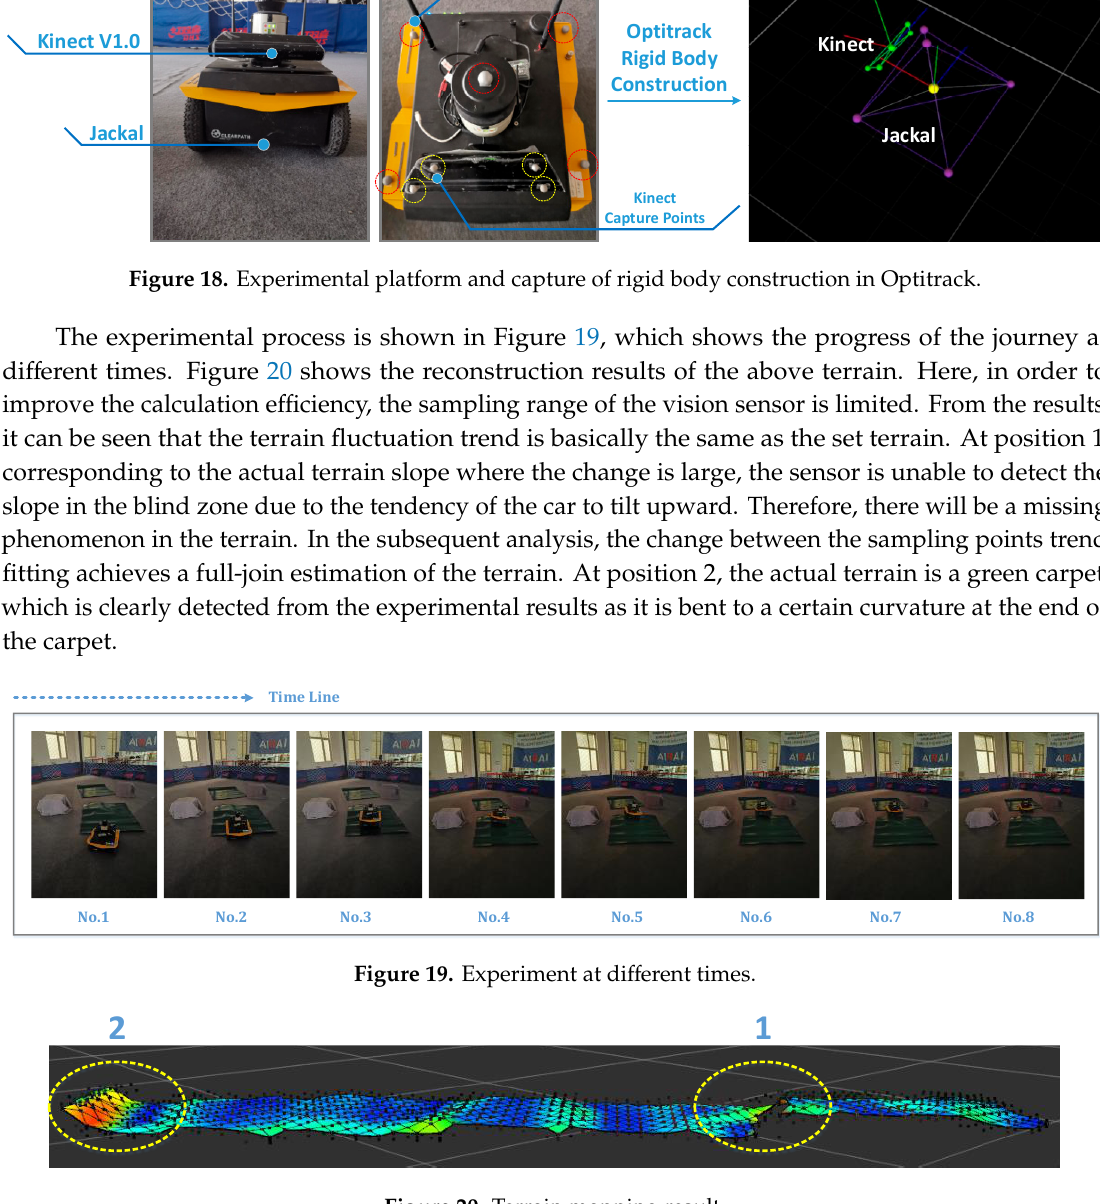
Figure 17. The indoor verification environment.